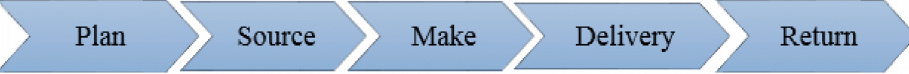
Figure 2. Characteristics of the cement supply chain (Agudelo, 2009)